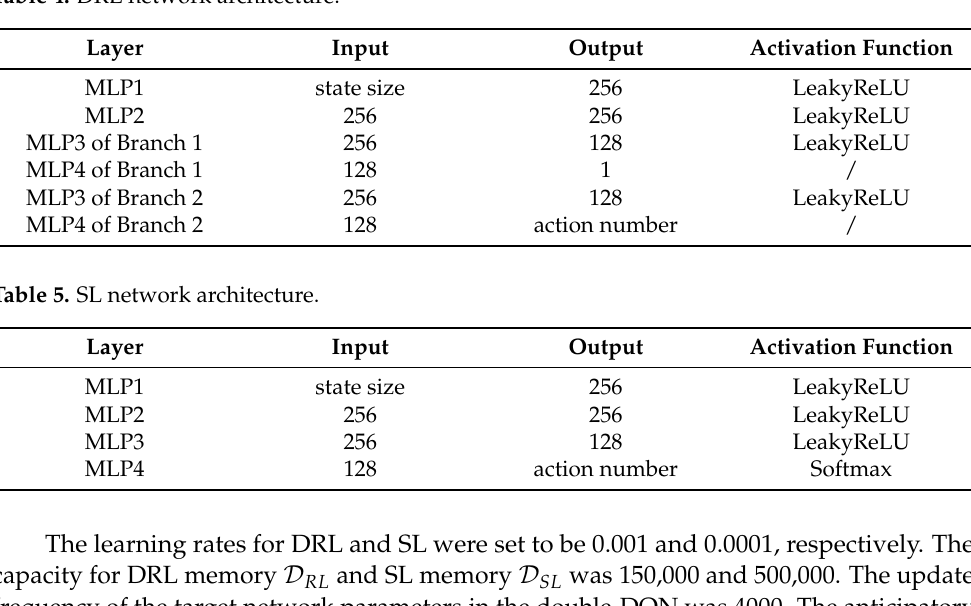
Table 4. DRL network architecture.